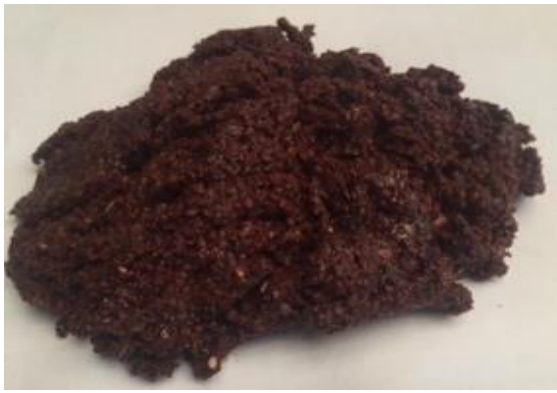
Figure 3. Mixing of gum Arabic–water–macadamia nutshell particles.